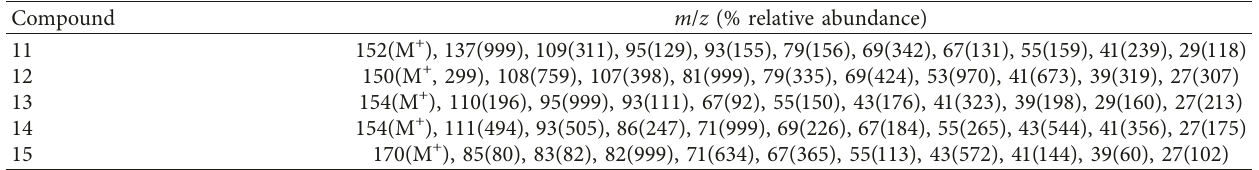
Table 17: Mass spectra of compounds 11–15 of whole plant n -hexane fraction of Achillea wilhelmsii (WHFAW). Compound